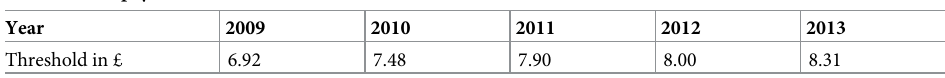
Table 1. Low-pay